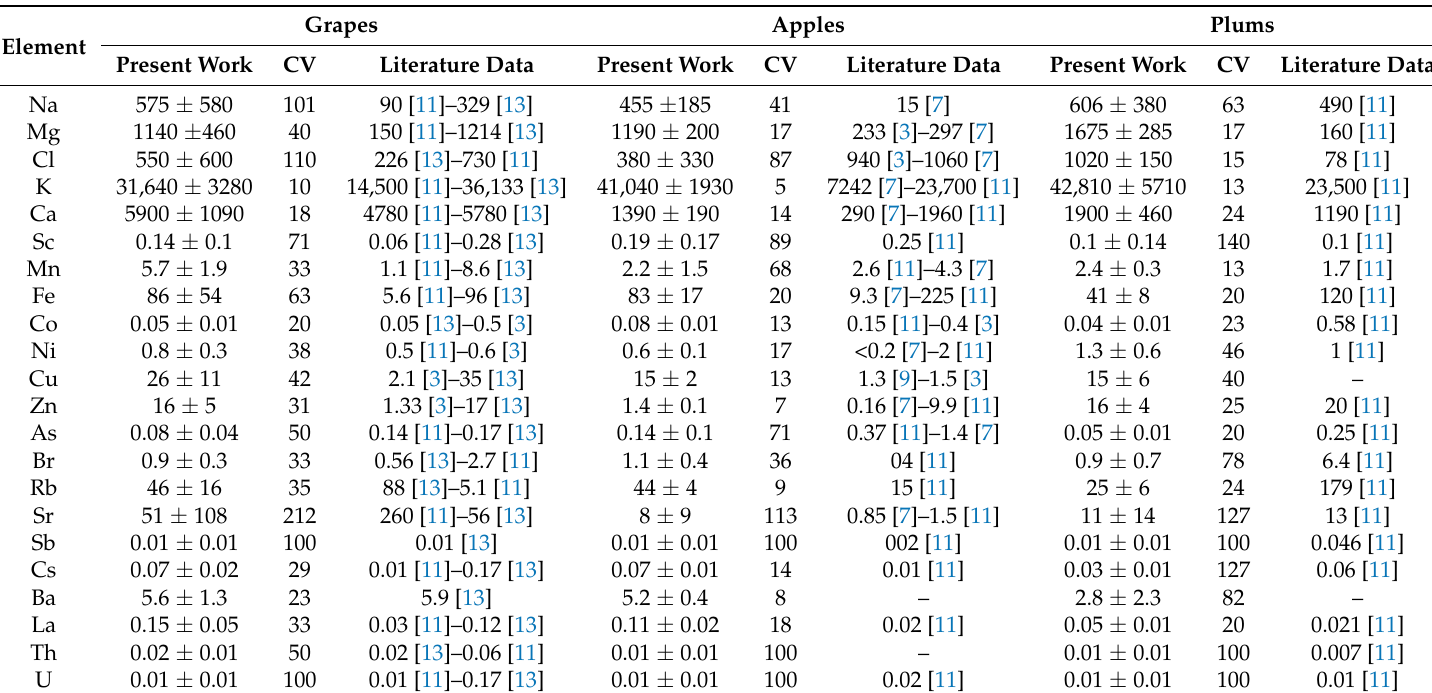
Table A2. The mass fractions ± total experimental uncertainty and Coefficient of Variation (CV) of the analyzed elements in fruits compared with existing literature data. CV expressed in %; mass fractions expressed in mg kg − 1